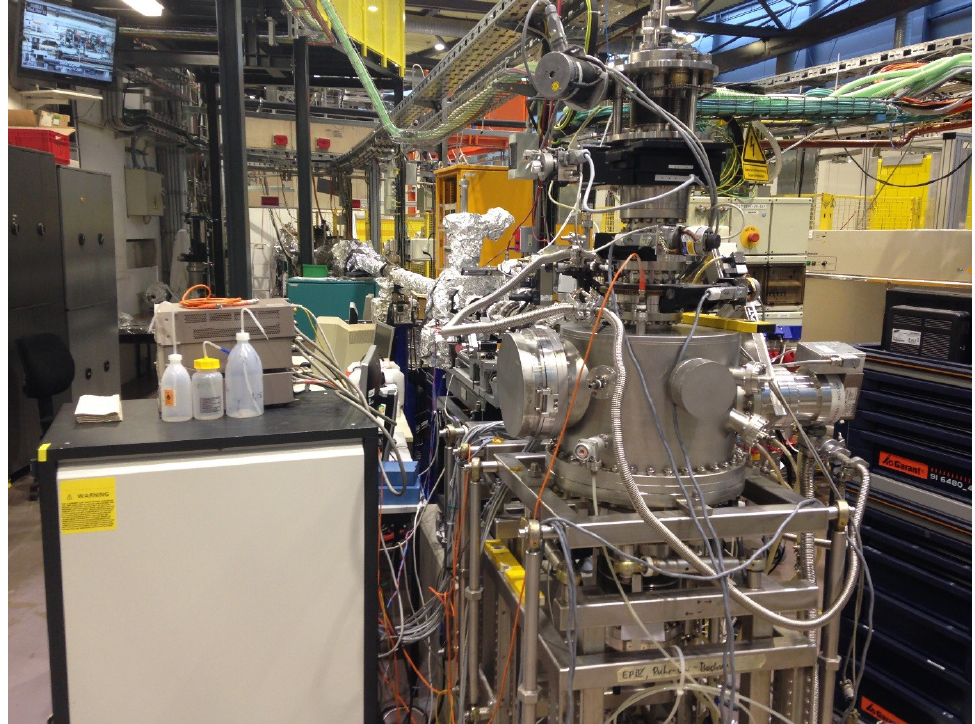
Figure 1: View of beamline PM3 (with user experiment chamber